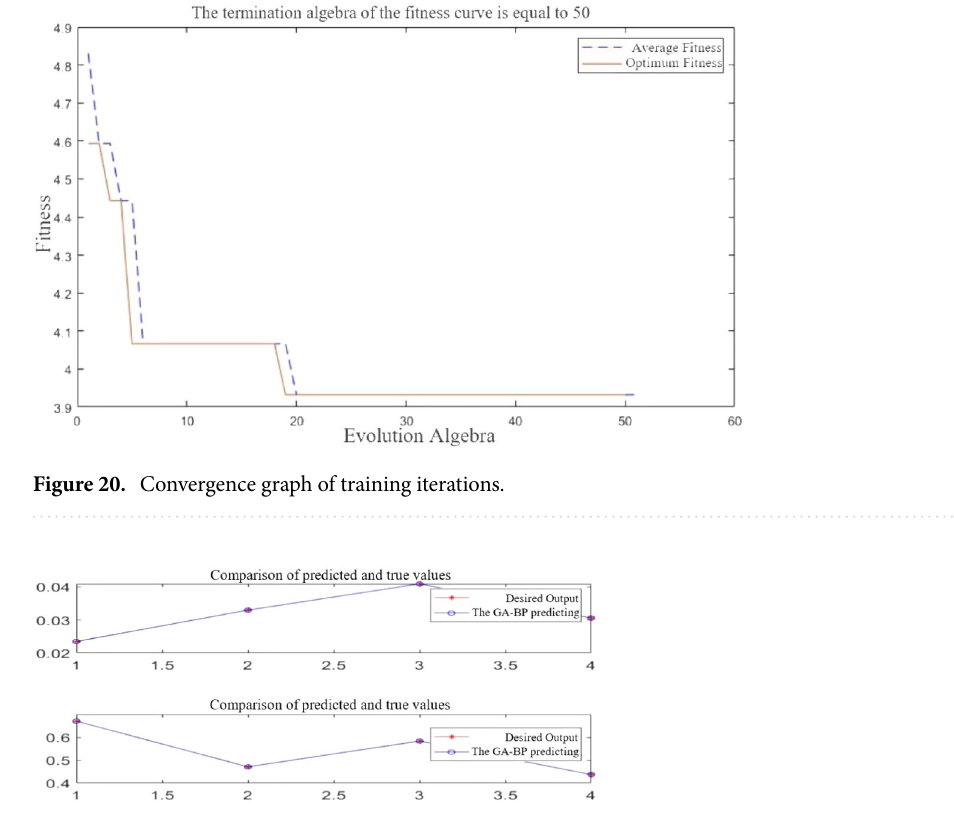
Figure 21. Comparison of GA-BP predicted and true